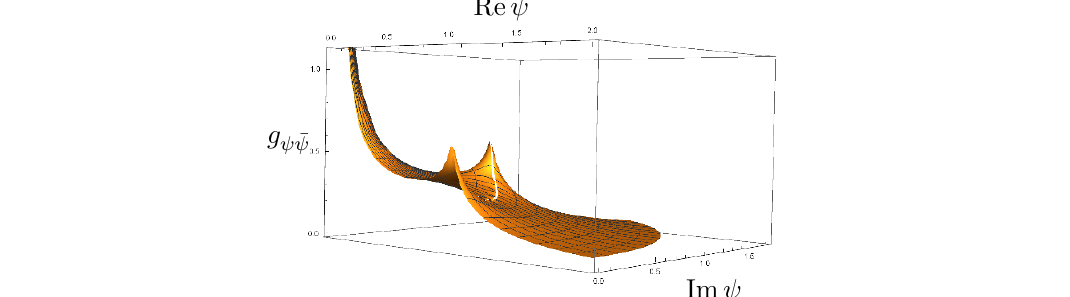
Figure 5 . Metric plot of